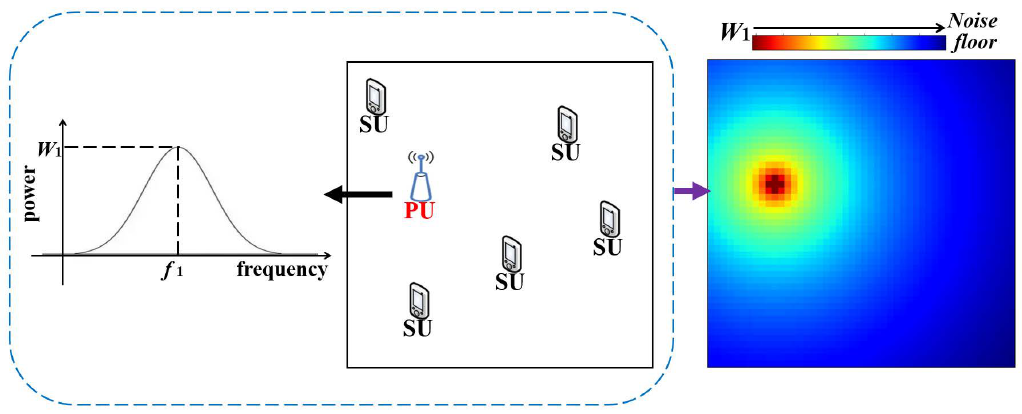
Figure 2. From left to right: The power spectrum of the primary user (PU); the distribution of the transmitting PU and receiving secondary users (SUs); the power spectrum map at frequency f 1